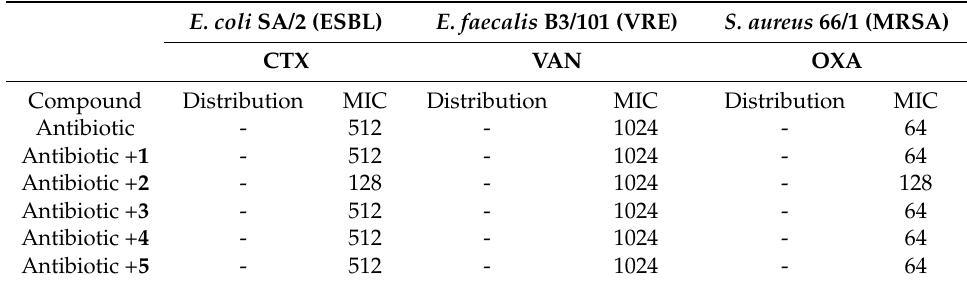
Table 4. Combined effect of clinically used antibiotics with 1 – 5 against multidrug-resistant strains. Minimal inhibitory concentration (MICs) are expressed in mg/L.